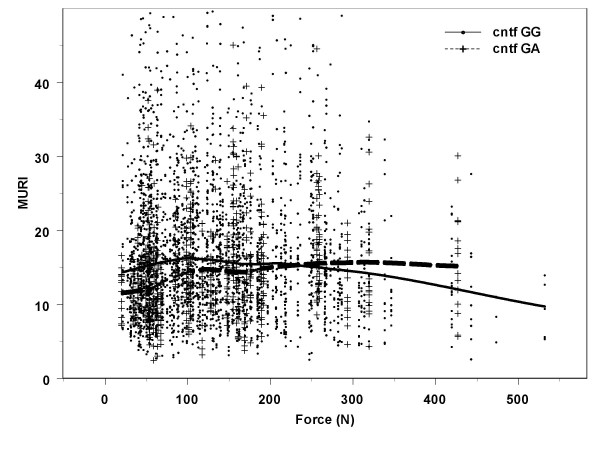
Relationship between knee extension force and the relative number of motor units active (MURI) for CNTF GG and GA genotypes. Data represent individual measurements with a loess regression line for each genotype. Statistical analyses are given in Table 3.